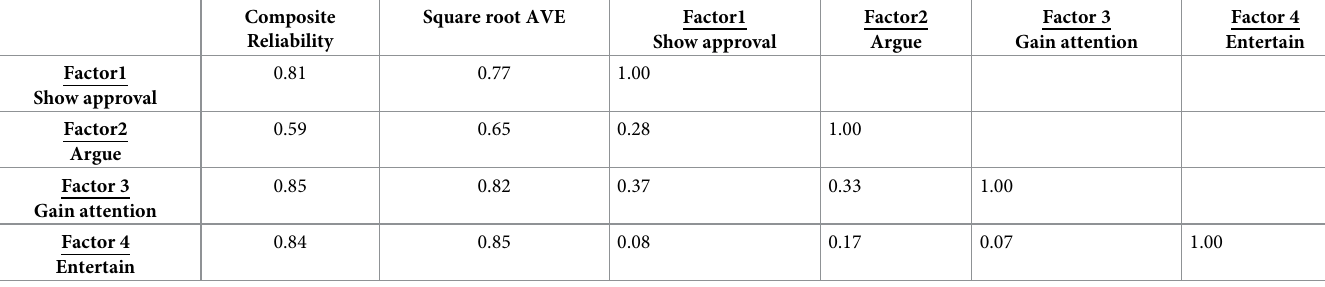
Table 4. Composite reliability, square root of factor AVE, and squared correlations between factors.